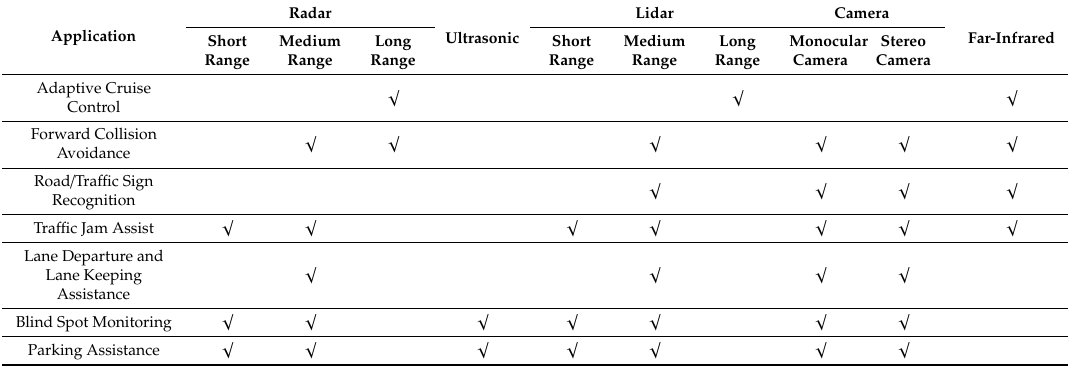
Table 4. A possible combination of sensors for all-weather